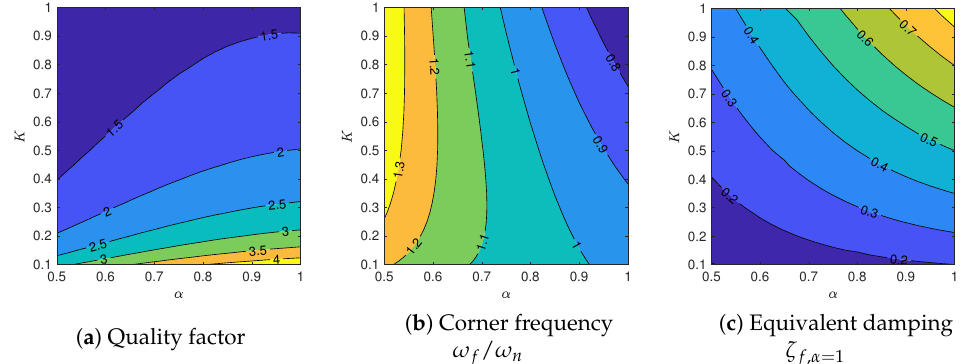
Figure 7. Optimal quality factor and tuning parameters for a single-mode plant with an FO NPF controller.